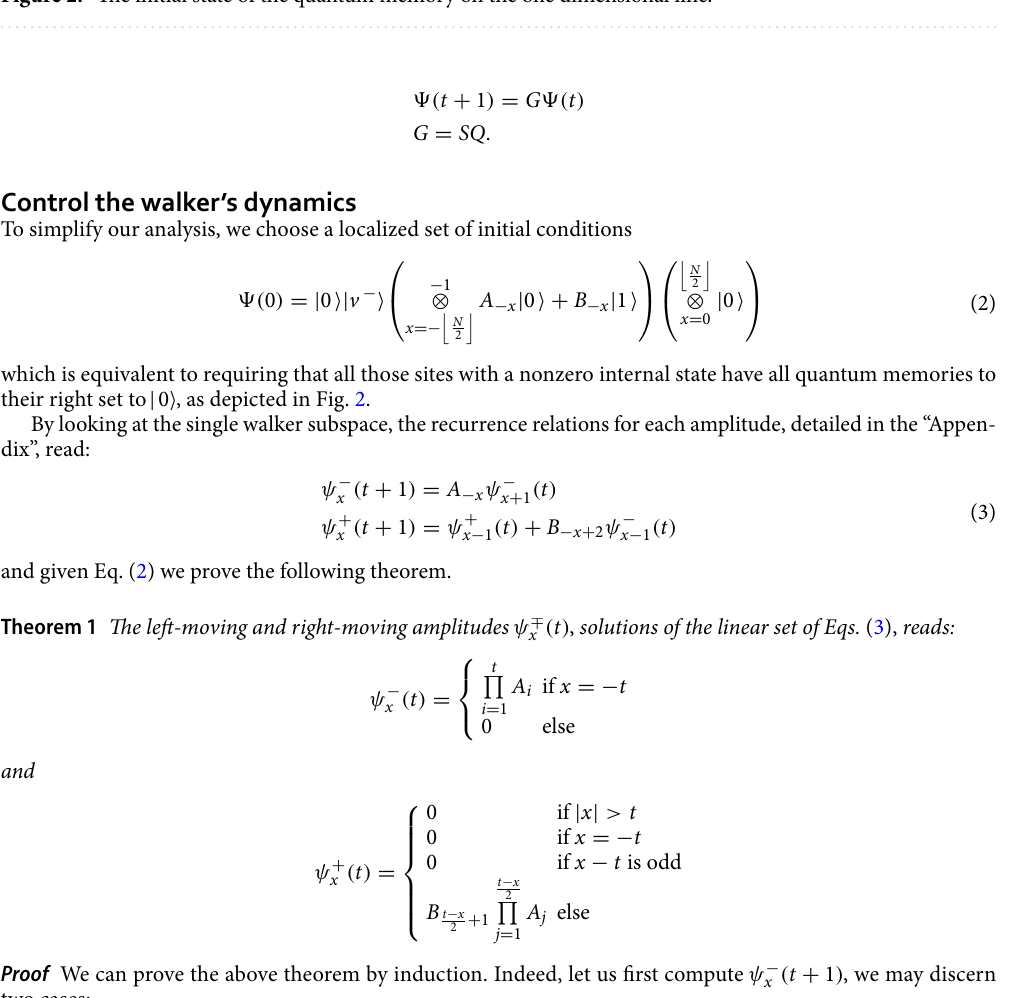
Figure 2. The initial state of the quantum memory on the one dimensional